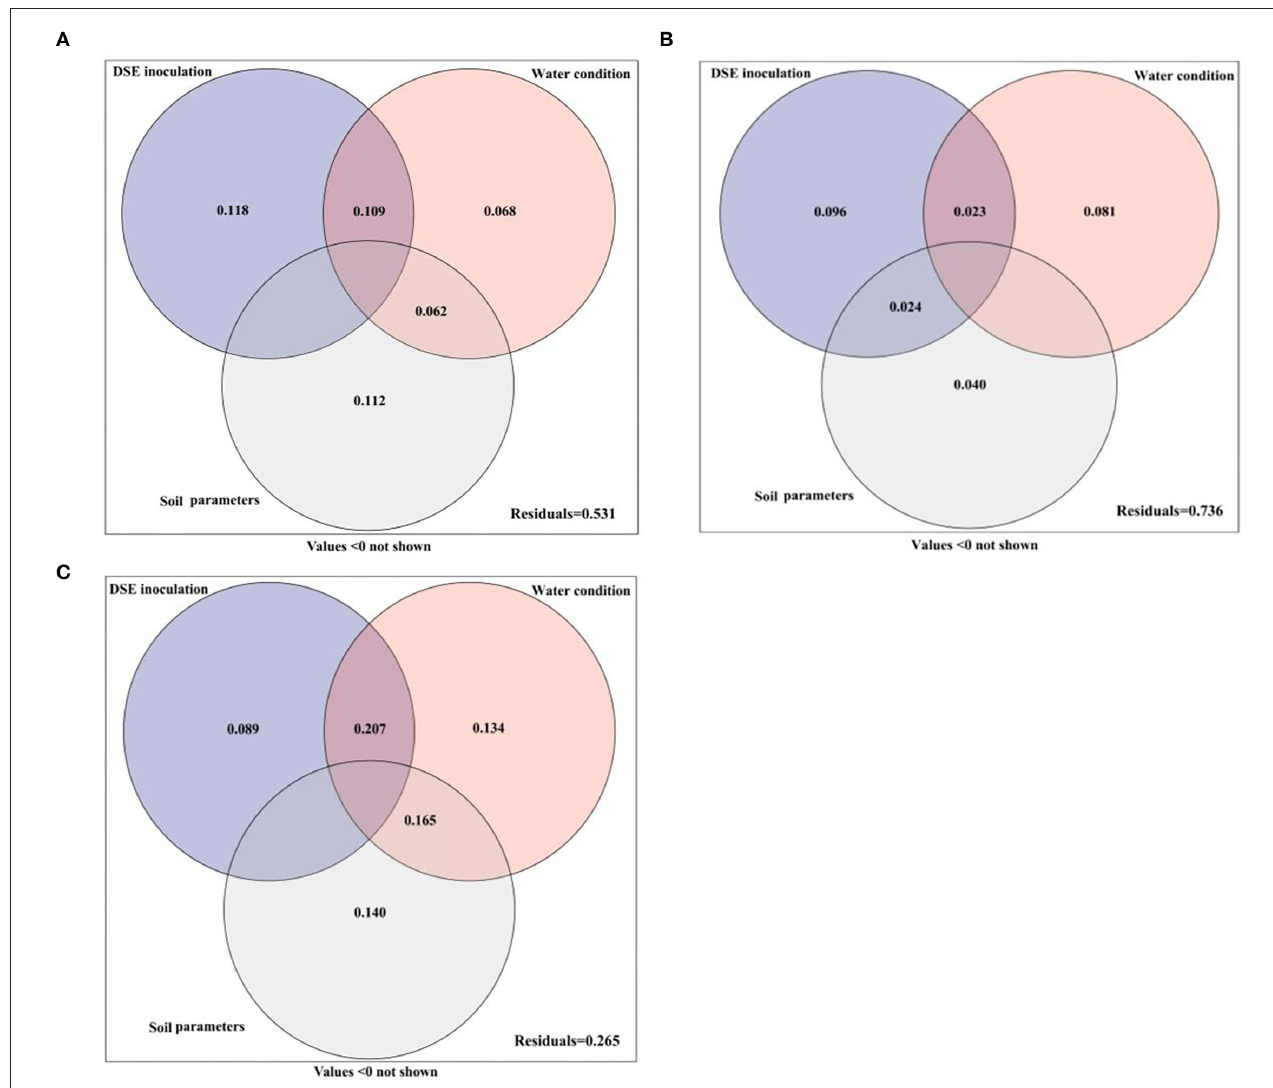
FIGURE 6 | Variation partitioning of DSE, water condition, and soil parameter on plant morphological (A) and physiological (B) parameters and soil microbes (C)